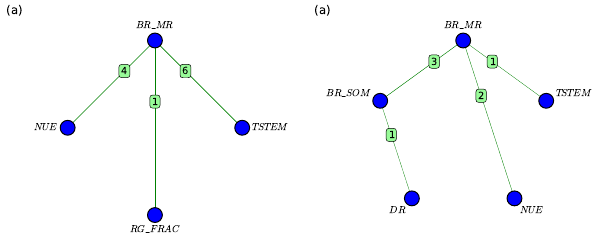
Figure 9. Relevant joint Sobol indices, S ij , corresponding to September averages for (a) TVC and (b) TSC. Both sets of results are based on D ST . The labels on each line show the magnitude, in %, of Sobol indices for the corresponding parameter